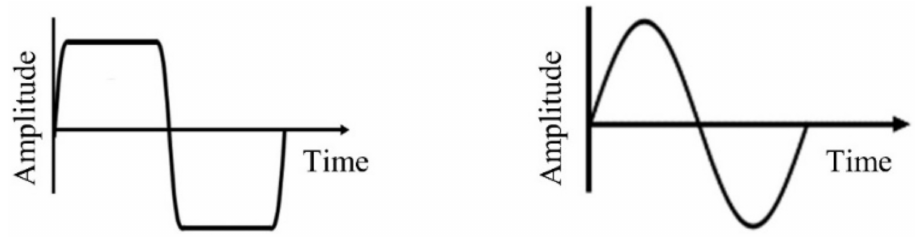
Figure 1. Vibration wave plot of square and sinusoidal wave-shaped